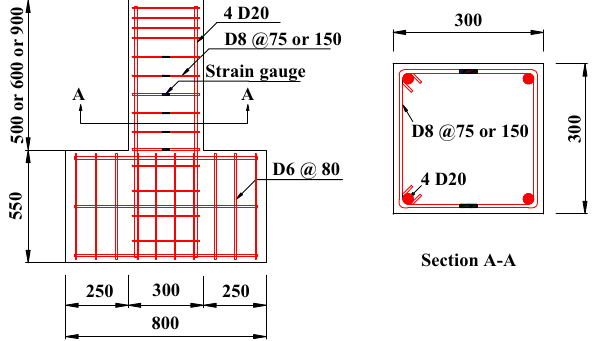
Fig. 8 Geometry and reinforcement details (unit: mm).